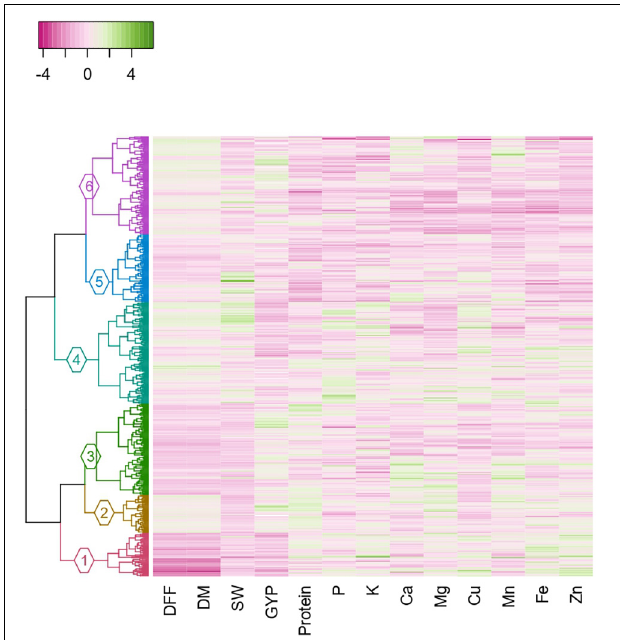
FIGURE 6 | Dendrogram constructed based on the Gower’s distance matrix, adopting Ward. D2 clustering method with heatmap depicting the agronomic and grain nutrient content in each accession of the cluster (DFF, days to 50% flowering; DM, days to maturity; SW, 100-seed weight; GYP, grain yield per plant; P, phosphorus; K, potassium; Ca, calcium; Cu, copper; Mg, magnesium; Mn, manganese; Fe, iron; Zn, zinc).